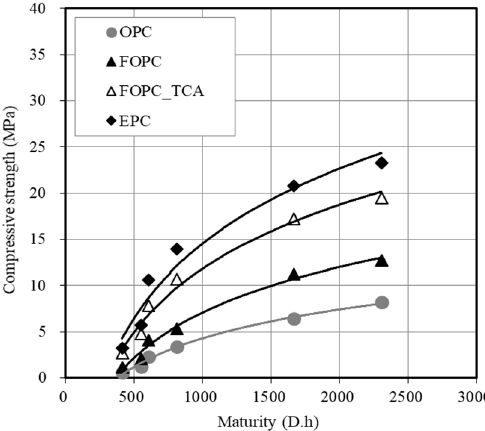
Figure 9. Comparison of maturity and early strength of concrete.